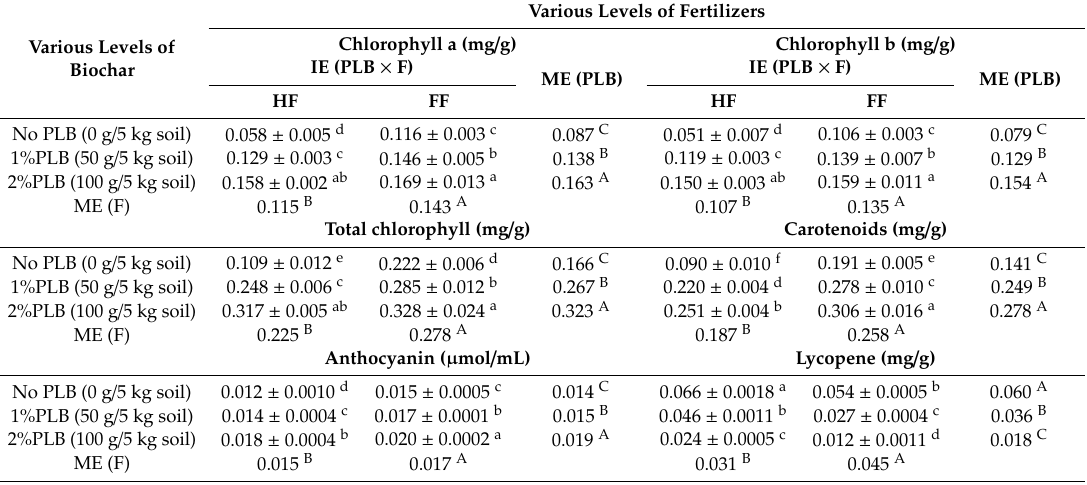
Figure 3. Effect of Pongamia pinnata L. leaves biochar (PLB 0, 1, and 2%) under HF and FF on Pisum sativum L. roots fresh and dry weights. Bars should be compared within a group (root fresh weight or root dry weight). Bar heights are different when there are no letters (a, b, c) are common ( p < 0.05). Table 3. E ff ect of variable rates of biochar (0, 1, and 2%) under HF and FF on the synthesis of the pigments in Pisum sativum